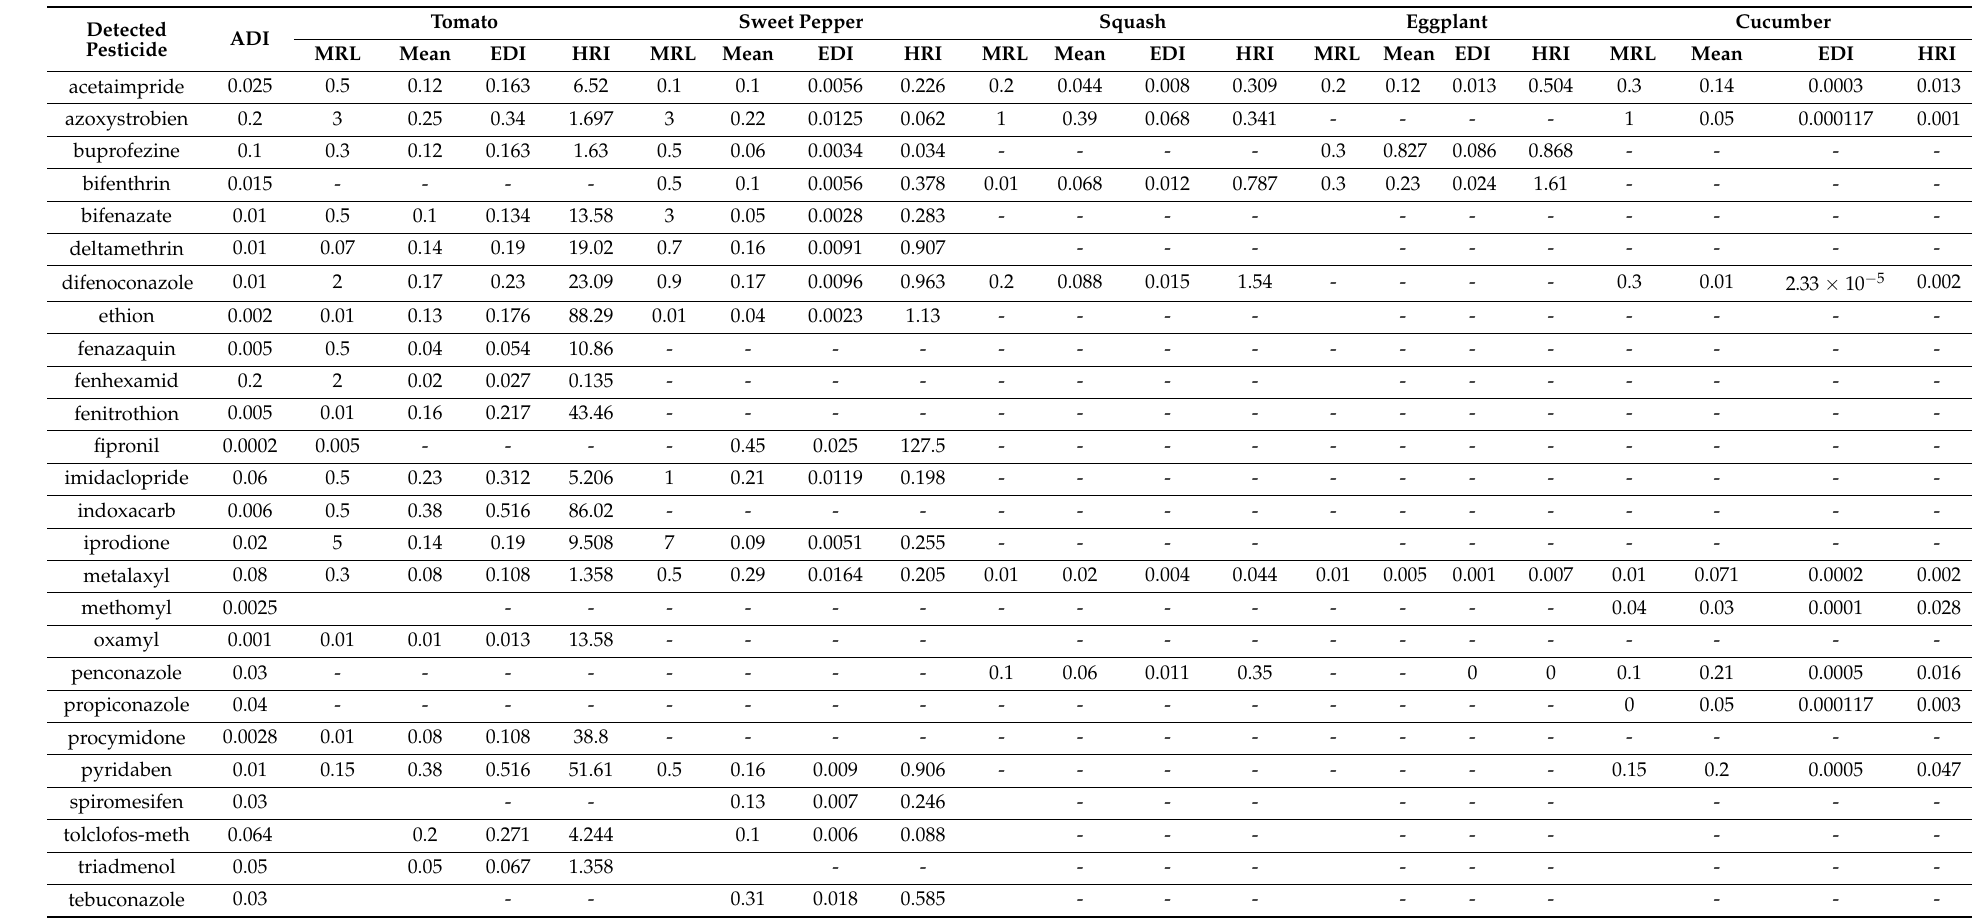
Table 3. Estimation of EDI and HRI for pesticide residues detected in Tomato, Sweet pepper, Squash and Cucumber